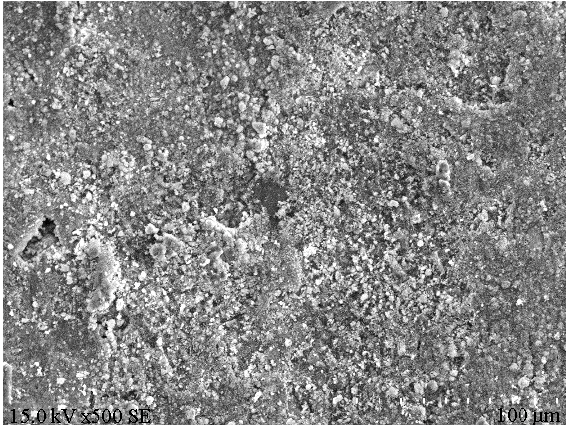
Figure 10. Microstructure of E1 samples.